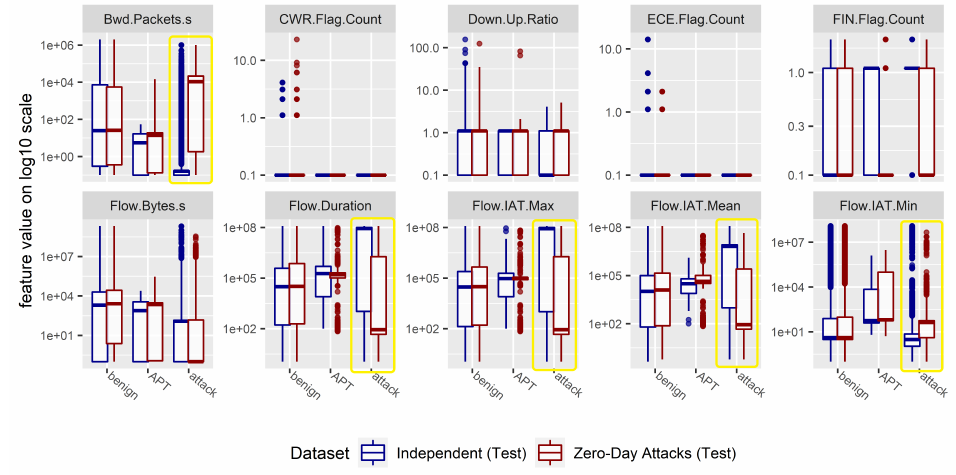
Figure 2. Boxplot comparison of statistical distributions for independent and zero-day